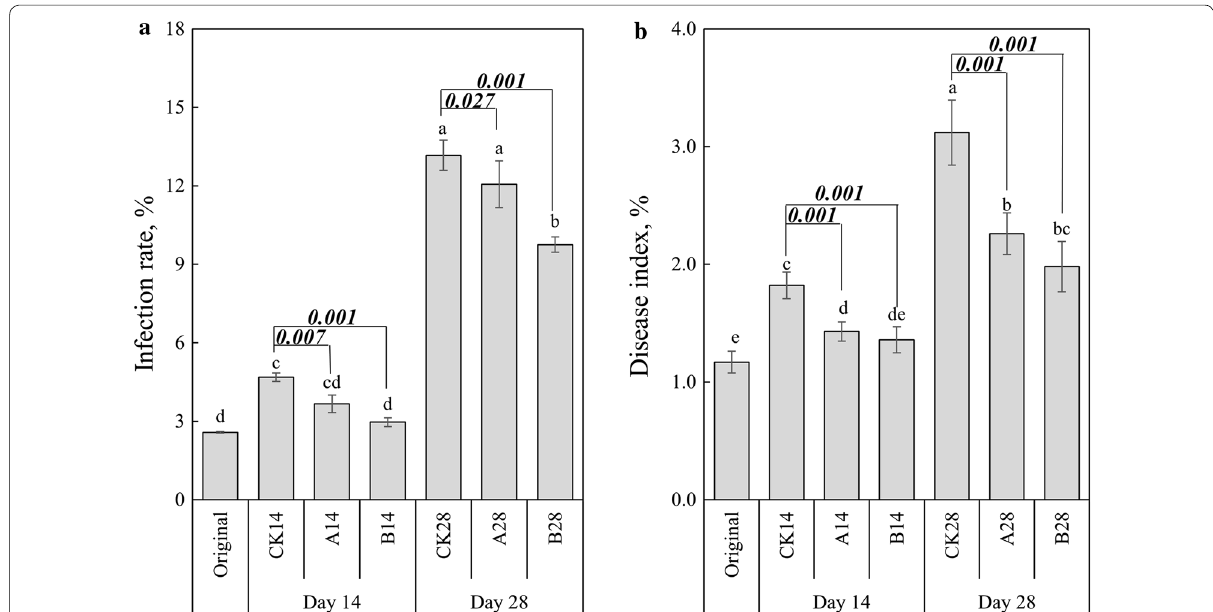
Fig. 1 Plant disease infection rate and disease index. Results are means and SD (error bar) of four replicates, statistically significant differences ( p < 0.05) in values between treatments are indicated through different letters above the columns, numbers between two columns are p values of student t